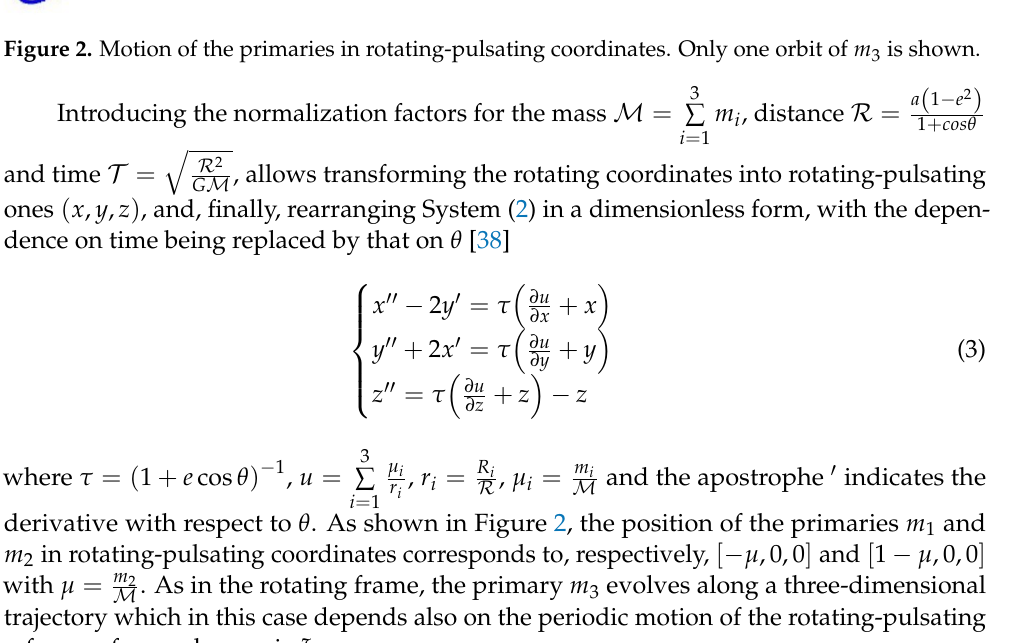
3 ∑ where τ = ( 1 + e cos θ ) − 1 , u = derivative with respect to θ . As shown in Figure 2, the position of the primaries m 1 and m 2 in rotating-pulsating coordinates corresponds to, respectively, [ − µ , 0, 0 ] and [ 1 − µ , 0, 0 ] with µ = m 2 . As in the rotating frame, the primary m 3 evolves along a three-dimensional M trajectory which in this case depends also on the periodic motion of the rotating-pulsating reference frame along axis ξ